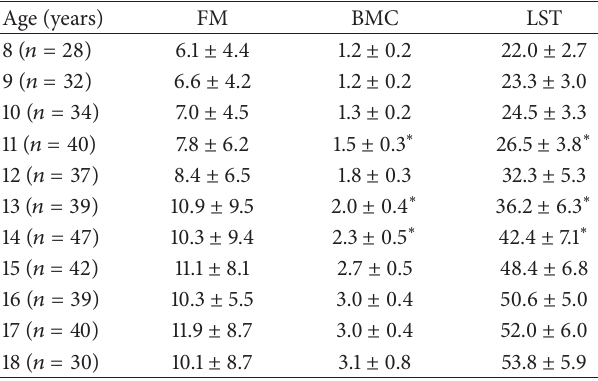
Table 4: Mean and standard deviation of DXA dependent variables by age